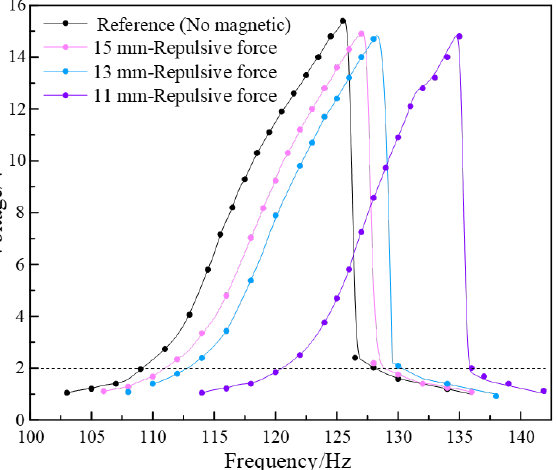
Figure 10. The load voltage in frequency domain under different repulsive modes.